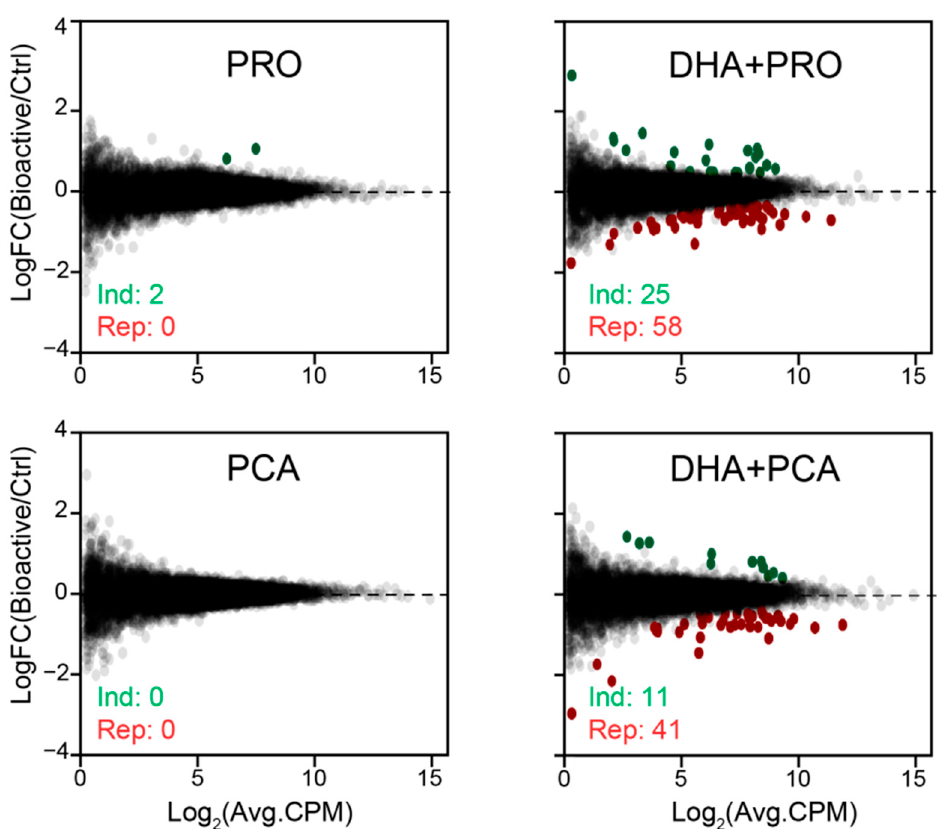
Figure 1. Global e ff ects of docosahexaenoic acid (DHA), propionate (PRO), protocatechuic acid (PCA) or combinations hereof on gene expression in HepG2 cells. Heatmap representing the e ff ects of the bioactives on the expression of genes found to be regulated by at least one of the bioactive conditions or combinations thereof. The expression is illustrated as scaled tag counts (using scale function in R) clustered by bioactive e ff ects. Data in this figure represents 3 biological replicates. MA plots showing the transcriptional e ff ect of 24 h supplementation with bioactives. LogCPM = log 2 normalized sequence counts per million (CPM), LogFC = log 2 fold change (FC) in expression between control and bioactive treatment. Green and red dots represent significantly induced and repressed genes (adjusted p -value ≤ 0.05, log 2 CPM > 0, log 2 FC > 0 (induced) or log 2 FC < 0 (repressed)), respectively.